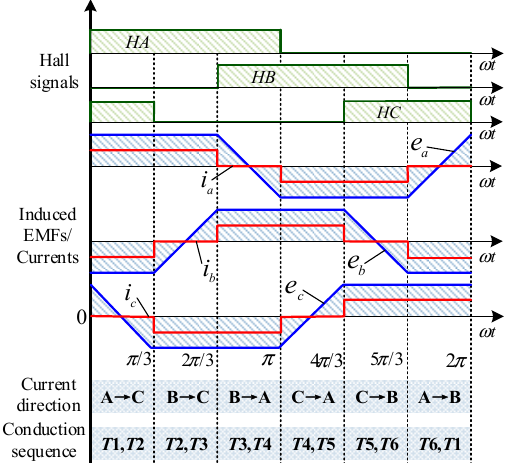
Figure 2. Operating principle in the clockwise cycle.